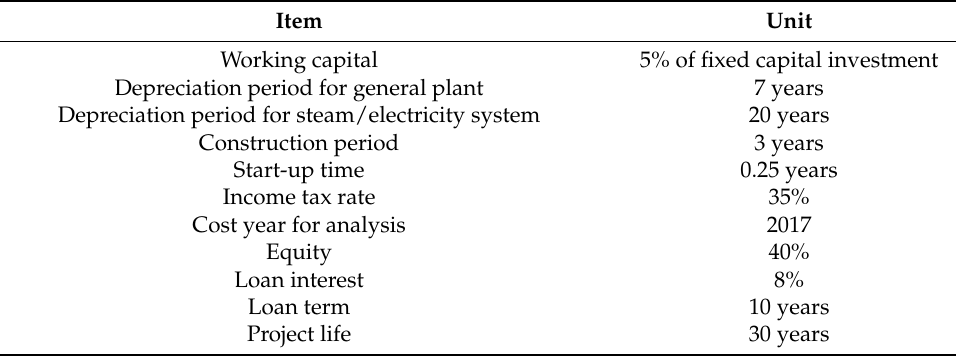
Table 3. Summary of assumptions made for discounted cash flow